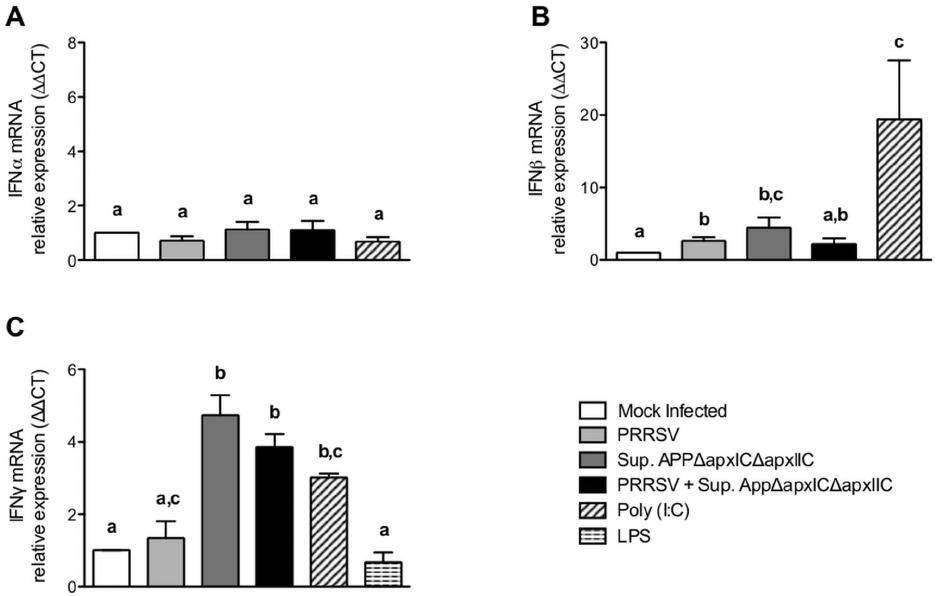
Figure 6. App D apxI D apxIIC cell culture supernatant and PRRSV effects on mRNA quantification of type I (IFN a , IFN b ) and type II (IFN c ) interferons. qRT-PCR results expressed in relative expression ( DD CT) for IFN a (A), IFN b (B) and IFN c (C) in SJPL cells. The cells were mock infected or infected with 0.5 MOI of PRRSV for 4 hours then treated without or with App D apxIC D apxIIC cell culture supernatant for 48 hours. Poly (I:C) and LPS were used as positive controls. Data labeled with superscripts of different letters indicates that these sets of data are statistically different (P , 0.05).